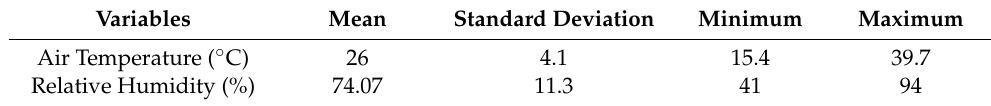
Table 1. Environmental conditions recorded during the experimental